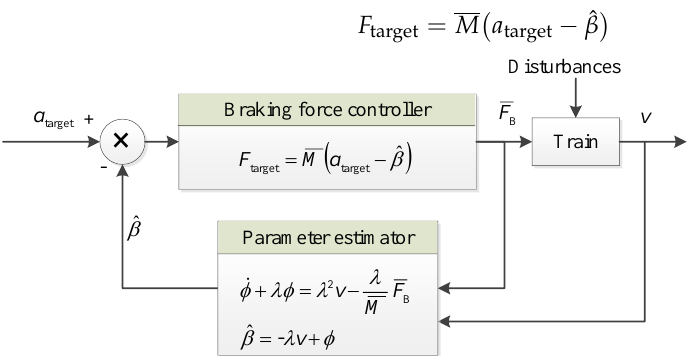
Figure 3. Schematic diagram of the deceleration controller.